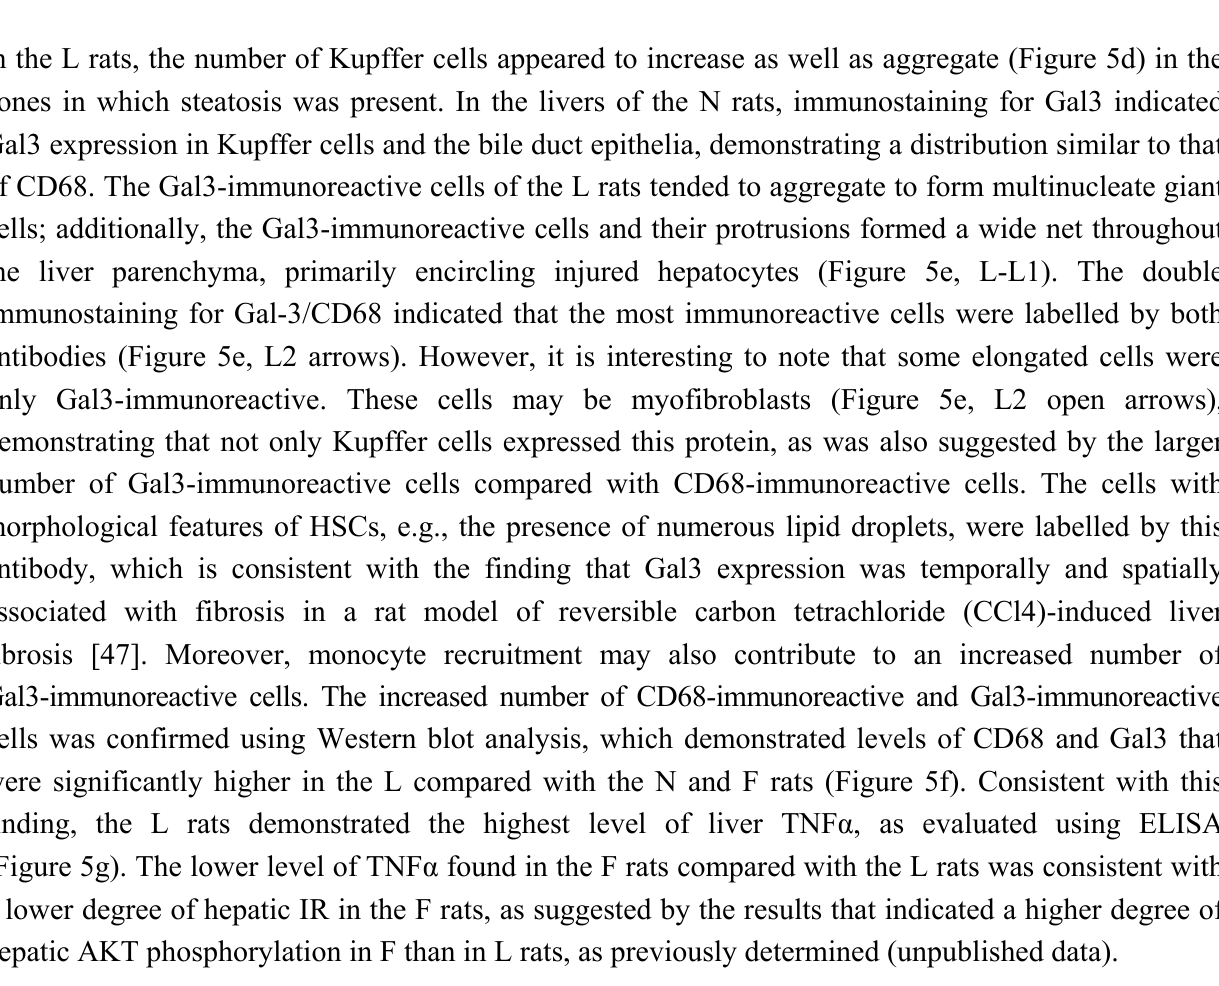
Figure 5. Hepatic steatosis and inflammation. ( a ) Semi-thin liver sections of rats fed a control diet (N), high-lard diet (L) or high-fish oil diet (F) that indicate the presence of lipid droplets in the L and F livers (arrows). OsO 4 and Toluidine blue stain; ( b ) Hepatic lipid content. The data are reported as fold increase vs. N rats ( N = 1) and represent the means ± SE for eight rats in each experimental group. * p < 0.05 compared with N rats; and # p < 0.05 compared with L rats; ( c ) N: a section of a control liver stained with PAS that indicates the glycogen depot. F: a section of an F liver with an infiltration of inflammatory cells (arrow) surrounded by degenerating hepatocytes, as observed by the loss of glycogen and indicated by negativity to the PAS reaction (open arrow). The other neighbouring hepatocytes contained PAS-positive glycogen. L: A section of an L liver with arrows indicating inflammatory foci along the course of the central vein. The infiltrated cells were primarily mononuclear with some neutrophils. The inset shows an apoptotic body surrounded by mononuclear and neutrophil cells at higher magnification. L1: A section of an L rat liver that shows an apoptotic body surrounded by Kupffer cells (arrows) and another cluster of phagocytic cells (double arrows). L2: A section of an L rat liver that shows ballooning hepatocytes (arrows); ( d ) CD68 immunostaining: N and L liver sections that show CD68-immunoreactive Kupffer cells localised in the liver sinusoids that demonstrate the difference in abundance of Kupffer cells between the N and L rats. L1 and L2: Higher magnification of two Kupffer cells; ( e ) Gal3 immunostaining: L and L1: